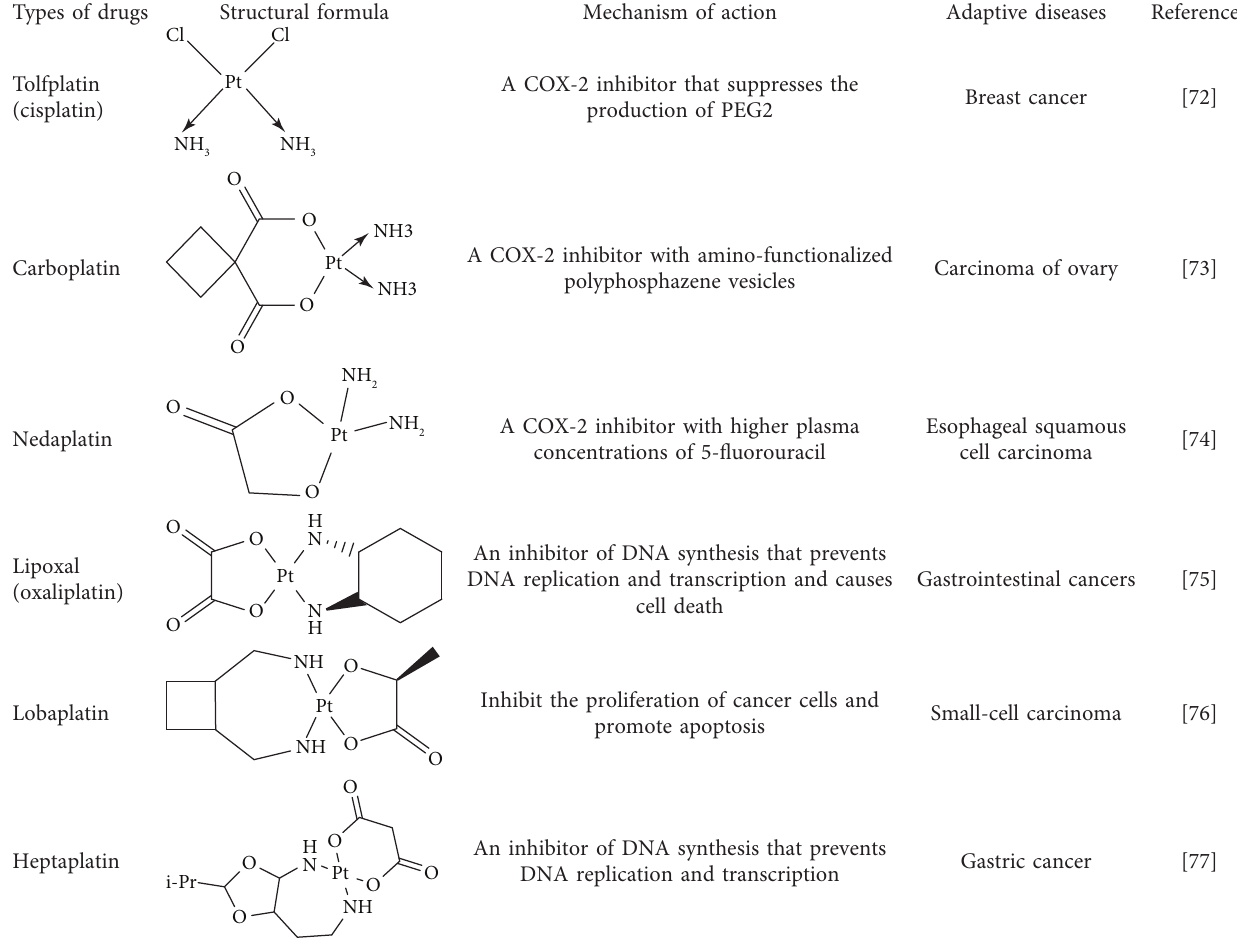
Figure 4: (a). Low-magnification SEM imaging of mesoporous platinum nanoparticles (Fu et al. [71]). (b). High-magnification SEM imaging of mesoporous platinum nanoparticles (Fu et al. [71]). (c). TEM imaging of mesoporous platinum nanoparticles (Fu et al. [71]). Table 2: Structure of platinum nanoparticles and indications in tumor therapy. Structural formula Mechanism of action Adaptive